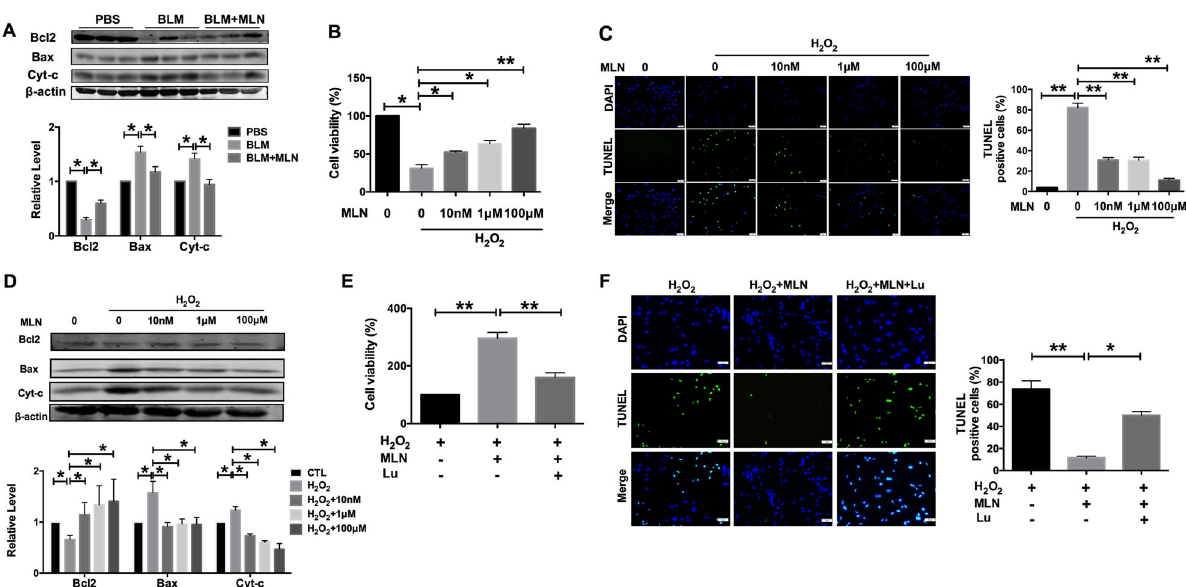
Fig. 2 Melatonin attenuated apoptosis during lung injury. a Immunoblot analysis showed the expression of apoptosis-related proteins (Bcl2, Bax, and Cyt-c) in the PBS, BLM, and BLM + MLN groups. TC-1 cells were treated with H 2 O 2 for 12 h with or without 10 nM, 1 μ M, or 100 μ M melatonin for 24 h. * P < 0.05. b An MTT assay was performed to assess TC-1 cells viability. n = 5; * P < 0.05, ** P < 0.01. c Left, a TUNEL assay was performed to detect apoptotic cells, and TUNEL-positive cells were counted in TC-1 cells. Green, TUNEL-positive TC-1 cells; blue, DAPI. Scale bars, 50 μ m. ** P < 0.01. d Immunoblot analysis of the protein expression of Bcl2, Bax, and Cyt-c. n = 5; * P < 0.05. e Luzindole inhibited the effect of melatonin on cell viability in TC-1 cells, as indicated by an MTT assay. n = 6; ** P < 0.01. f The number of TUNEL-positive cells was increased in the MLN + luzindole + H 2 O 2 group compared with that in the MLN + H 2 O 2 group. Green, TUNEL-positive TC-1 cells; blue, DAPI. Scale bars, 50 μ m. Right, relative percentage of TUNEL- positive TC-1 cells. * P < 0.05, ** P <